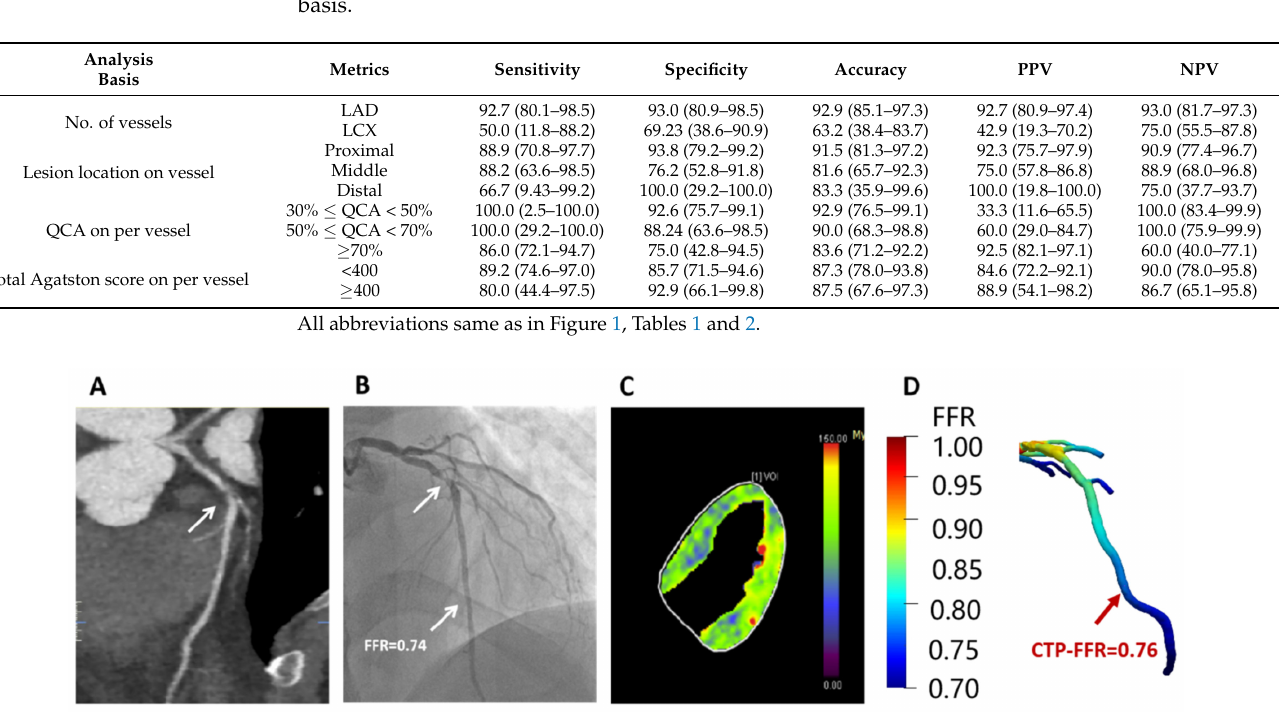
Figure 6. Example of a 47-year-old man who presented with atypical chest pain, hypertension and dyslipidemia. ( A ) CCTA shows stenosis (arrow) is caused by a mixed plaque of the proximal LAD. ( B ) ICA shows severe stenosis (arrow) with ischemia in LAD (FFR = 0.74). ( C ) Stress-CTP shows myocardial blood flow ( D ) CTP-FFR demonstrates value of 0.76 in the LAD. Abbreviations same as in Figure 1 and Table